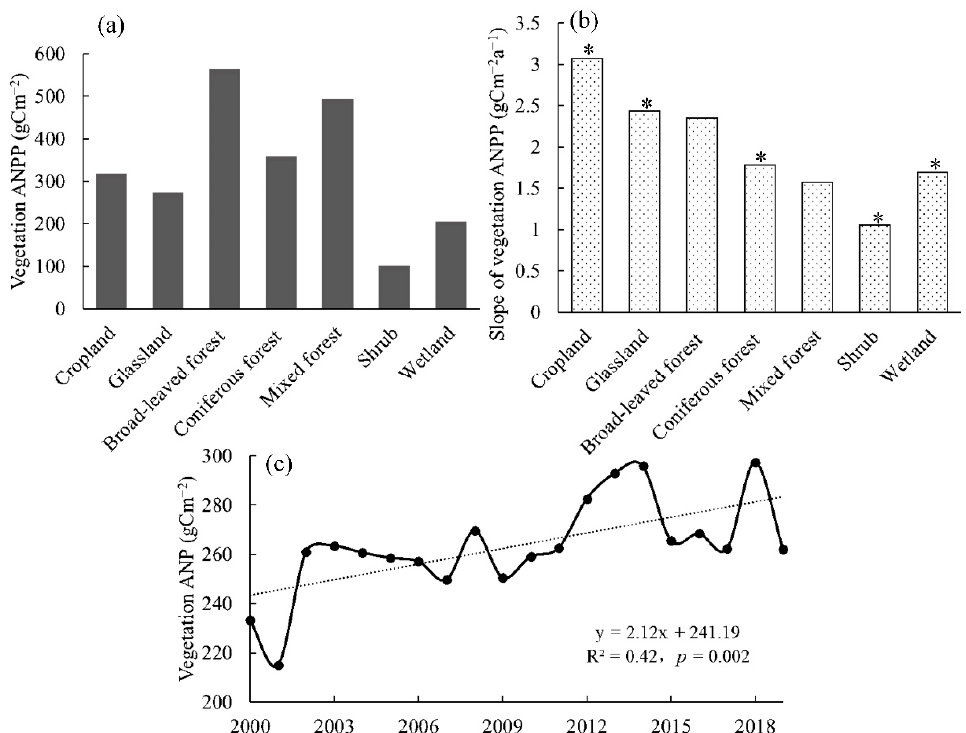
Figure 4. Spatial distribution of the multi-year average ANPP in the Mongolian Plateau from 2000 to 2019.